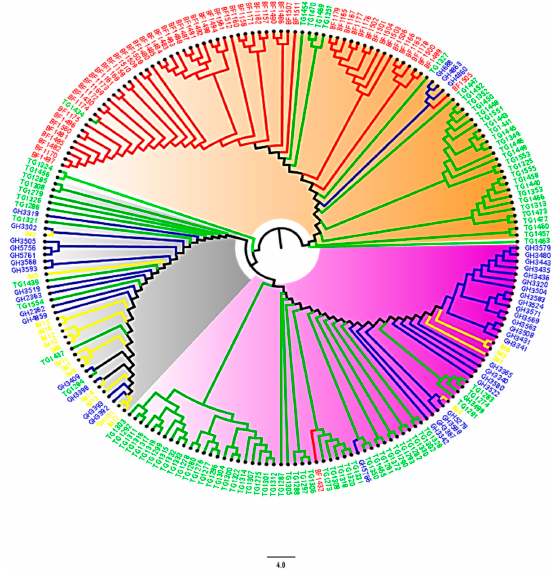
Figure 4. Cluster analysis of 208 maize accessions using principal coordinate analysis (PCoA). Accessions are colored according to origin. The orange, ash, and violet circles represent subpopulation 1, 2, and 3, respectively.